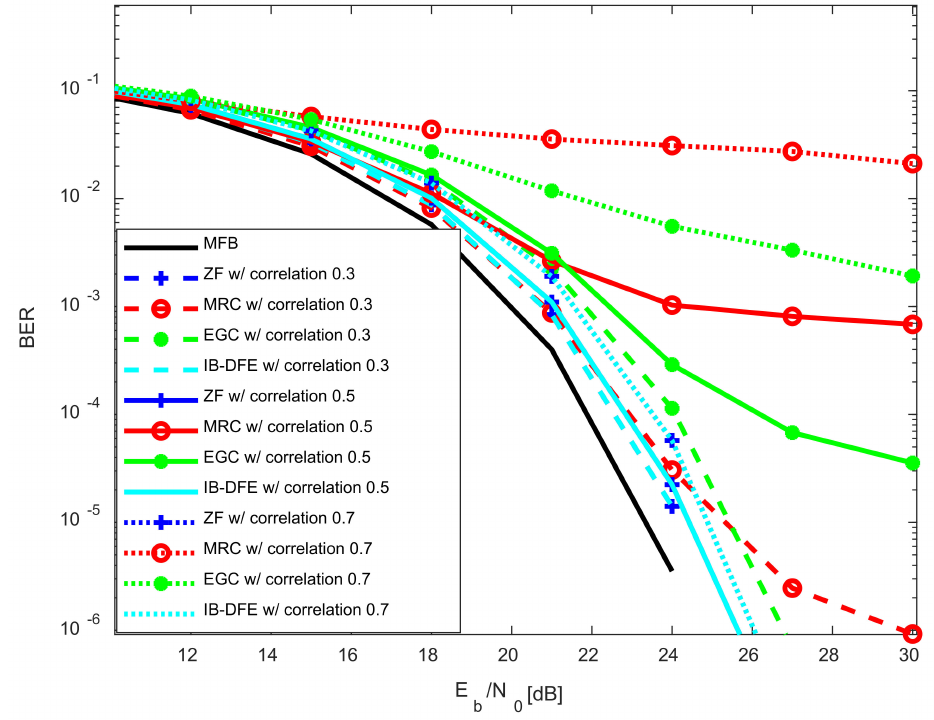
Figure 7. Results for 4 × 32 MIMO, with channel estimation, impulsive noise, LDPC codes, and channel correlation 0.3 versus 0.5 and 0.7 between antenna